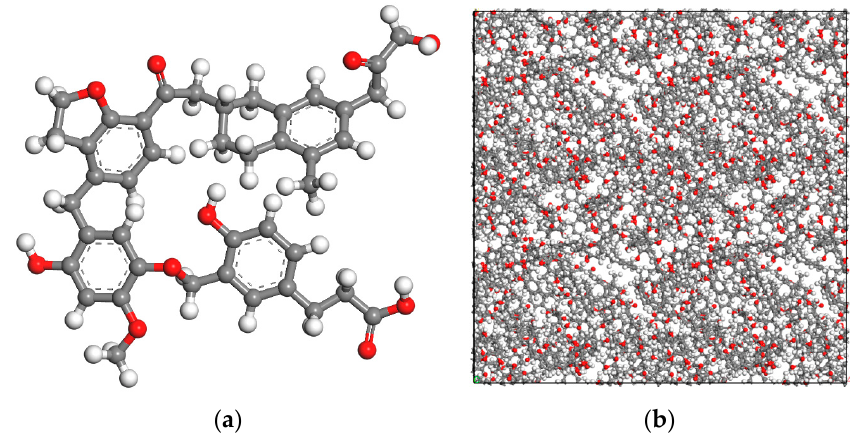
Figure 1. Wender coal molecule ( a ) and top view of the coal surface ( b ) (C in gray, O in red, H in white). To study the e ff ect of water on the oil adsorption process, water slabs containing 8000 water molecules were constructed using an amorphous cell module. A dodecane droplet was placed at the top of the water slab. A vacuum section with a thickness of 80 Å was added at the top to avoid the e ff ect of periodic boundary conditions (PBC). The coal-water-collector system (CWC) is presented